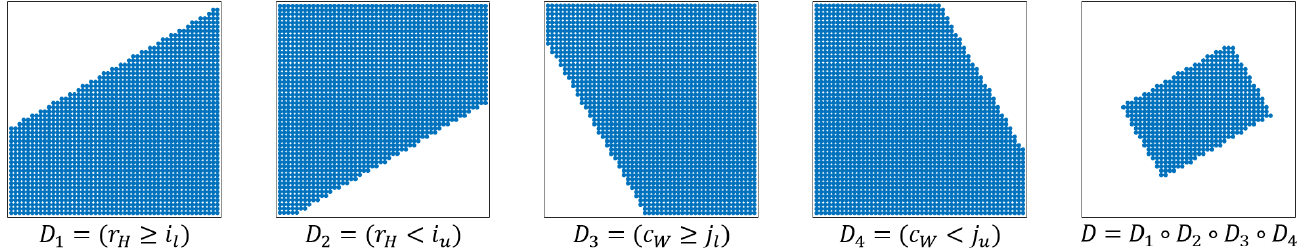
Figure 3. The constituent matrices ( D 1 , D 2 , D 3 , D 4 ) and resulting representation ( D ) for an exemplary rectangle. The final object representation is attained by performing elementwise multiplication of four constituent matrices obtained by using simple vector